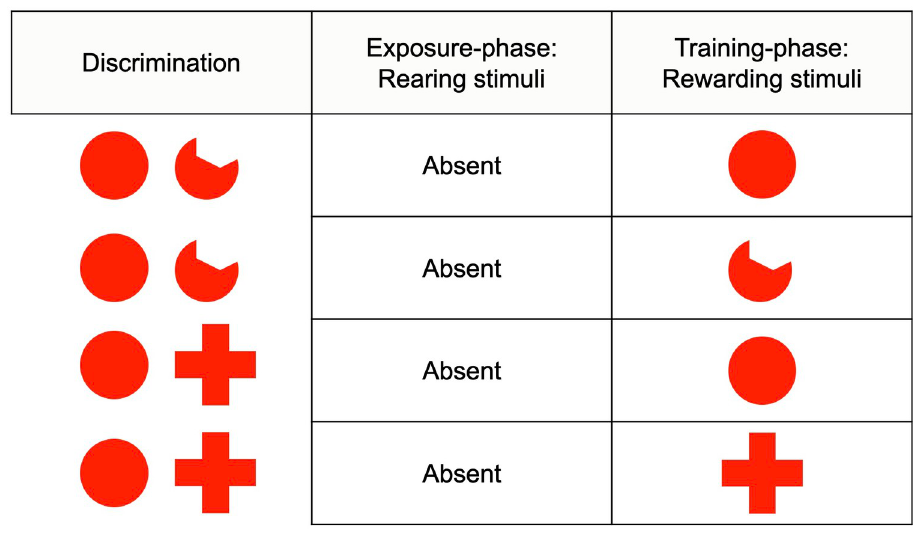
Fig 5. Overview of Experiment 3. Four experimental groups were arranged, two for the full red disk-amputated red disk discrimination (fish trained on the full red disk, fish trained on the amputated red disk), and two for the full red disk-red cross discrimination (fish trained on the full red disk, fish trained on the red cross), all in the absence of an exposure-phase. 1 ( Visual discrimination learning between a full red disk and an amputated red disk ) and in Experiment 2 ( Visual discrimination between a full red disk and a red cross ). The apparatus and the procedure were the same as those used in Experiment 1 and 2 .